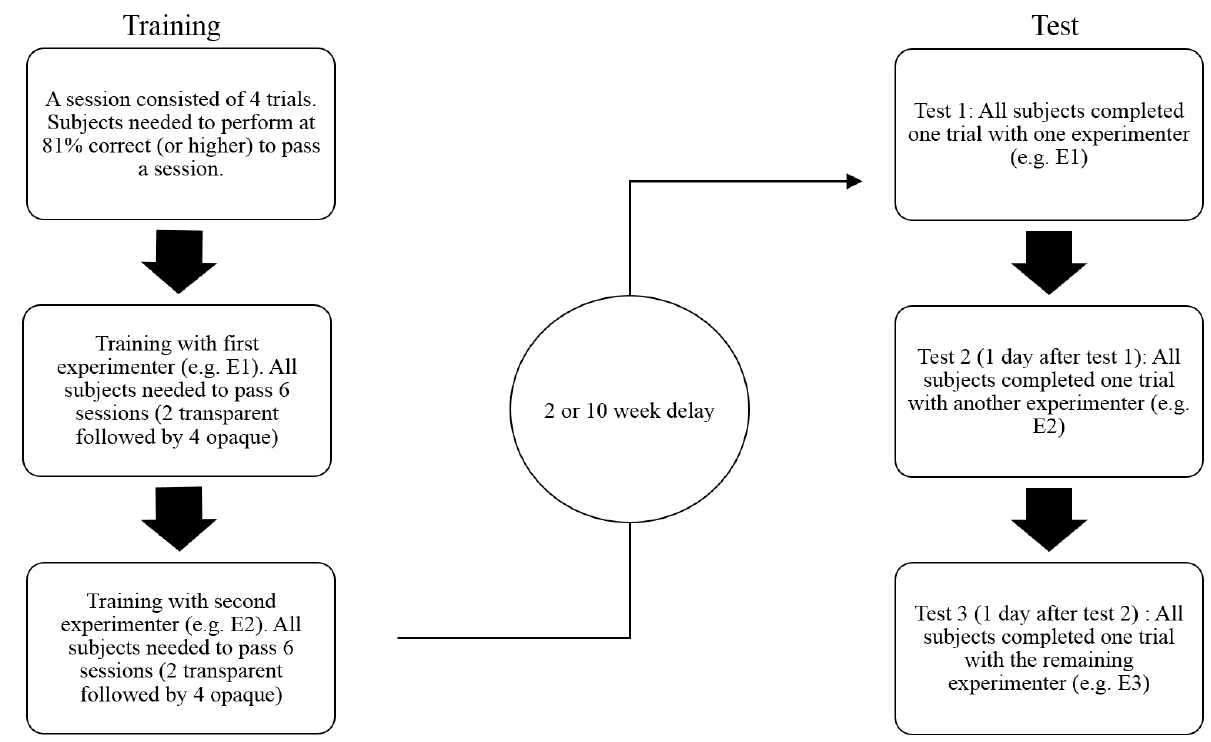
Figure 3 . Example order of training and test